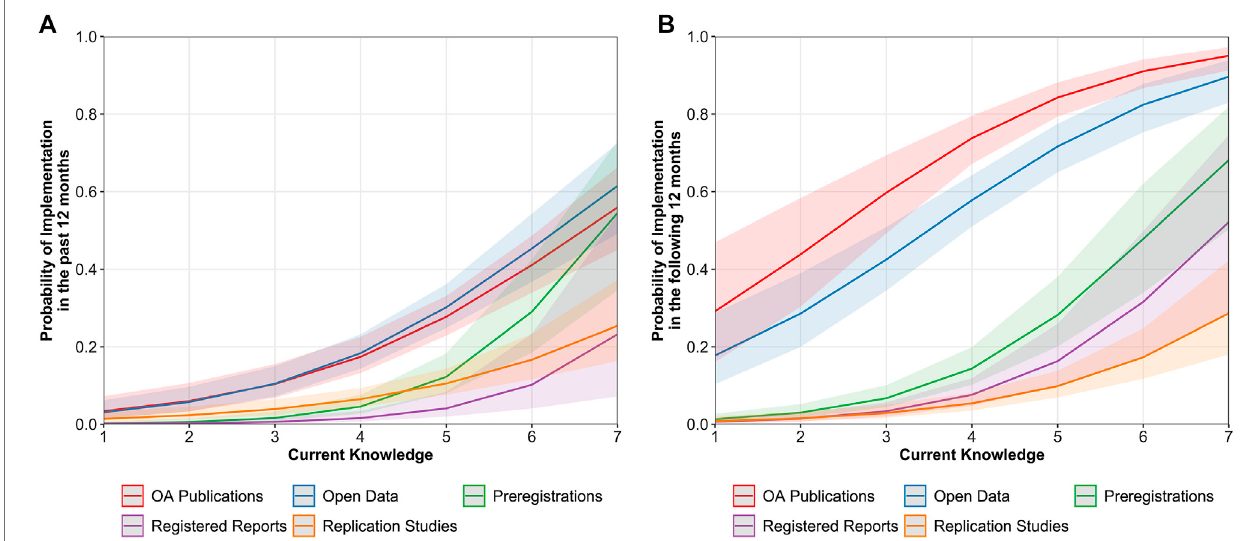
FIGURE 8| Predicted values ofimplementation in the past 12 months (A) and in the following 12 months (B) as afunction ofECRs ’ current knowledge across OS practices. Bandwidths represent 95% con fi dence intervals (CIs).